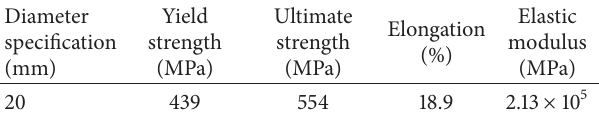
Table 2: Longitudinal steel parameter values.